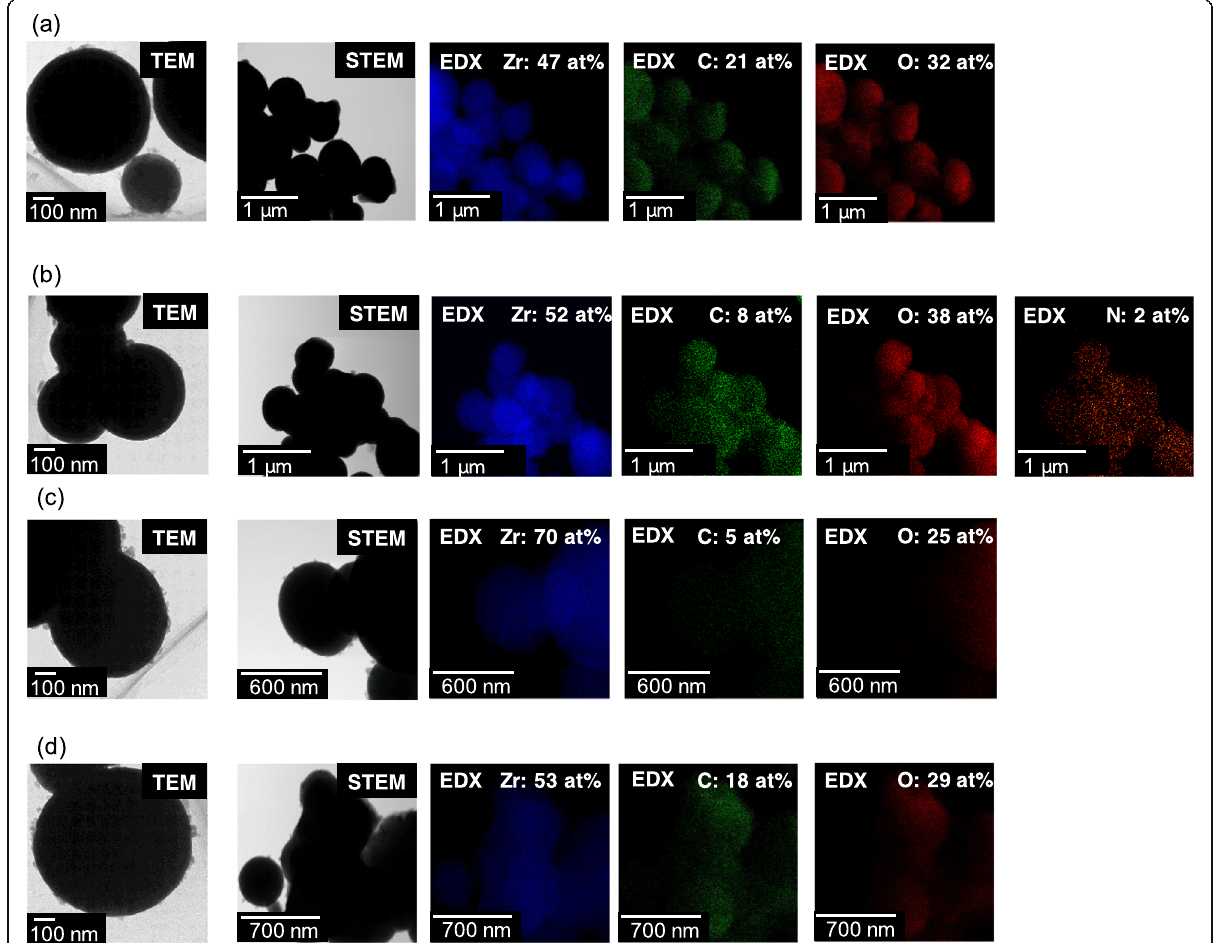
Fig. 5 TEM and STEM-EDX mapping images of a HEMA-impregnated ZrO 2 MARIMO, b NIPAM-impregnated ZrO 2 MARIMO, c BMA-impregnated